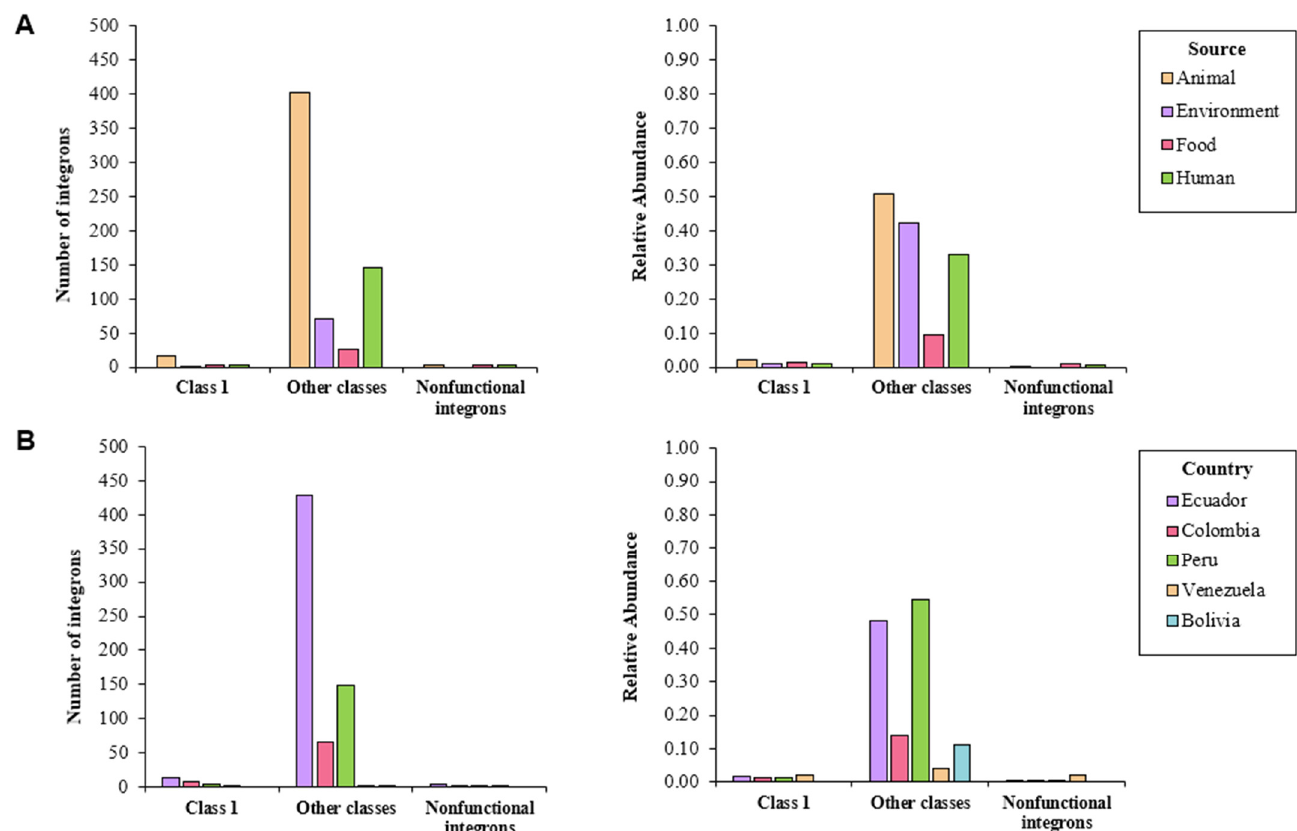
Figure 2. Number of integrons detected in whole-genome sequenced isolates of S. enterica according to I-VIP v1.2, classified by ( A ) source and ( B ) country.